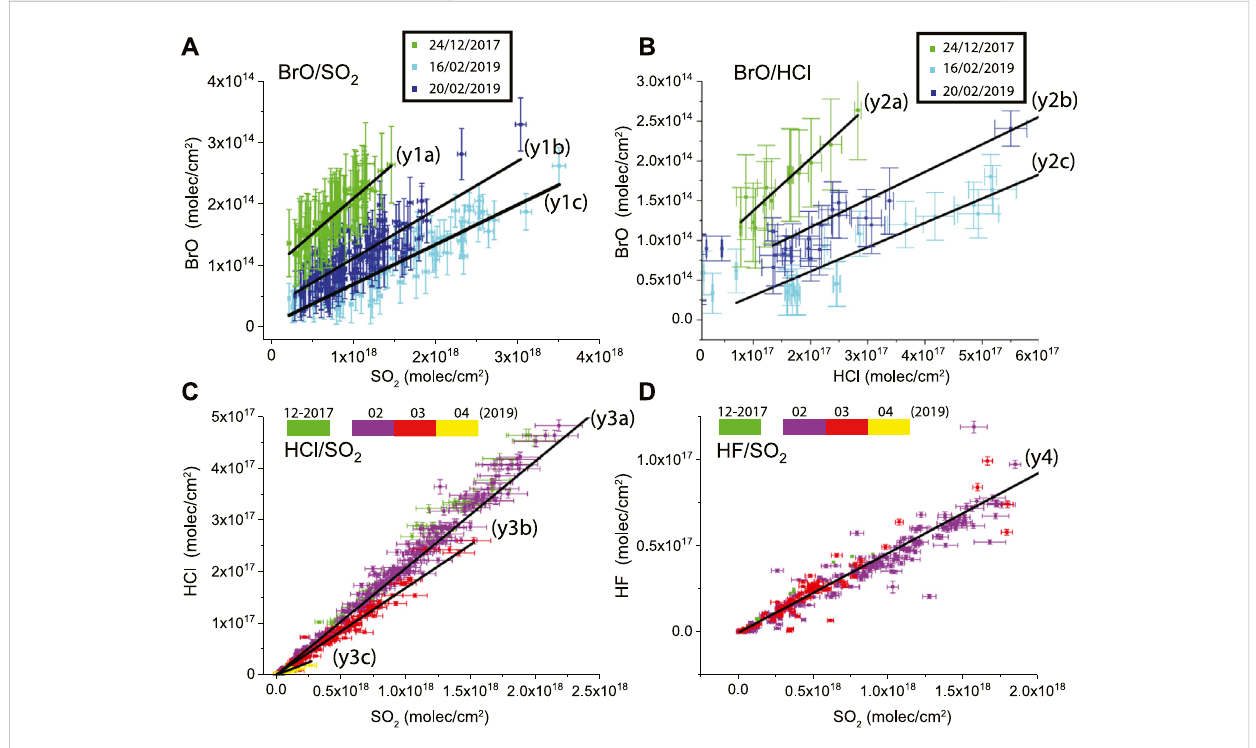
FIGURE 8 Correlationplotsof (A) BrOvs.SO 2 , (B) BrOvs.HCl, (C) HClvs.SO 2 and (D) HFvs.SO 2 VCscombiningDOASandFTIRdataon24December2017and during the February – April 2019 dome cycle. The BrO/SO 2 , BrO/HCl, HCl/SO 2 and HF/SO 2 ratios were determined from the slopes of the correlation plots.